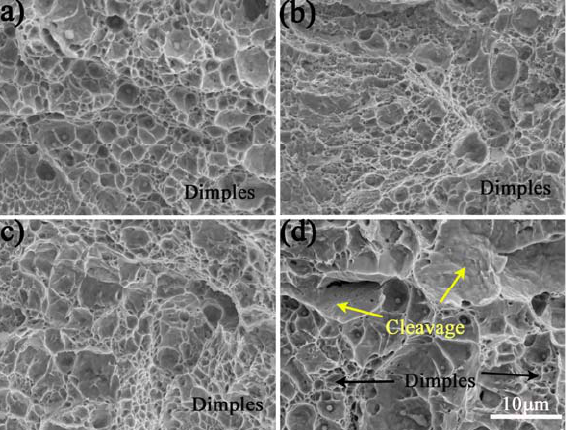
Figure 9. Impact fracture of deposited metals, ( a ) Cu 0.62, ( b ) Cu 1.38, ( c ) Cu 1.79, ( d ) Cu 2.32. There is mainly dimple of Cu 0.62, Cu 1.38, and Cu 1.79, while it are dimple and cleavage of Cu 2.32.